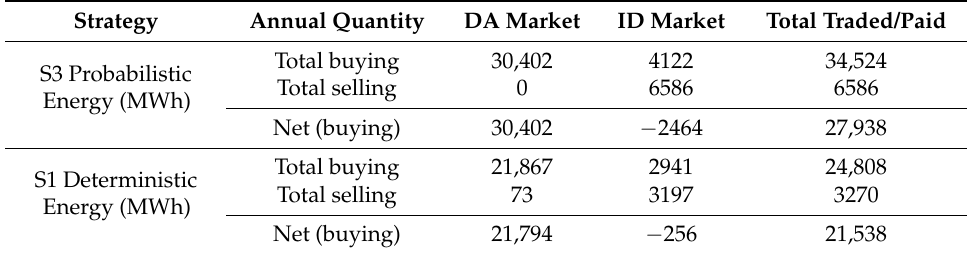
Table 7. Energy traded in DA and ID markets.